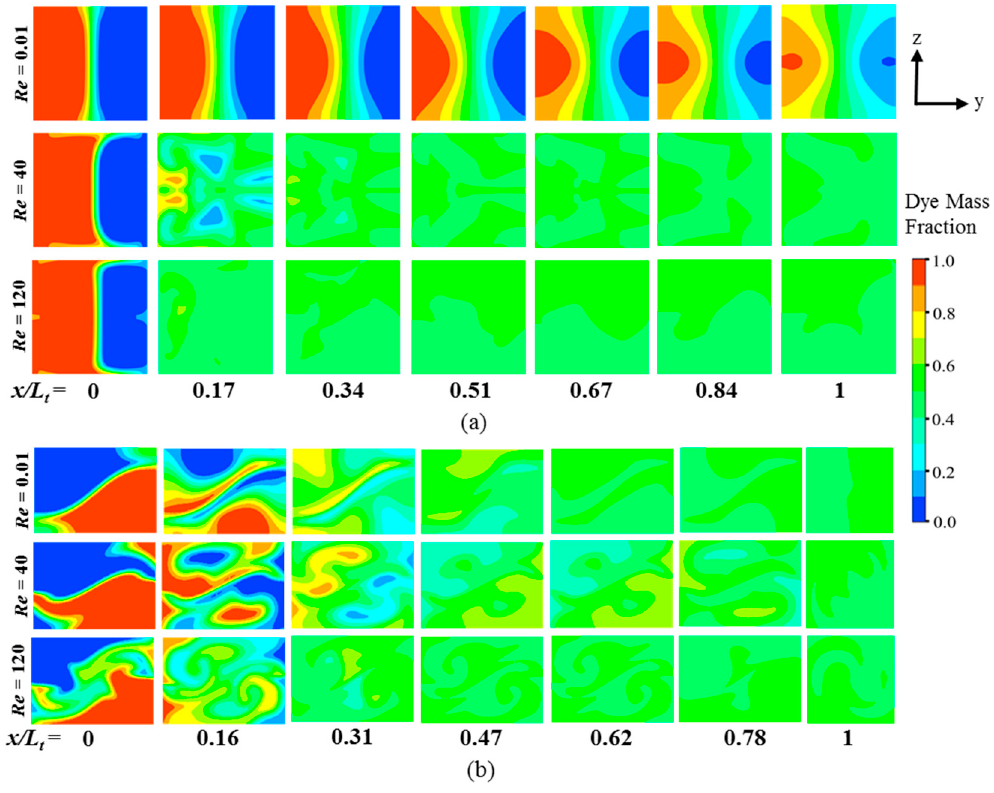
Figure 16. Dye concentration distributions at different Reynolds numbers: ( a ) M ‐ 4; and ( b ) M ‐ 10.